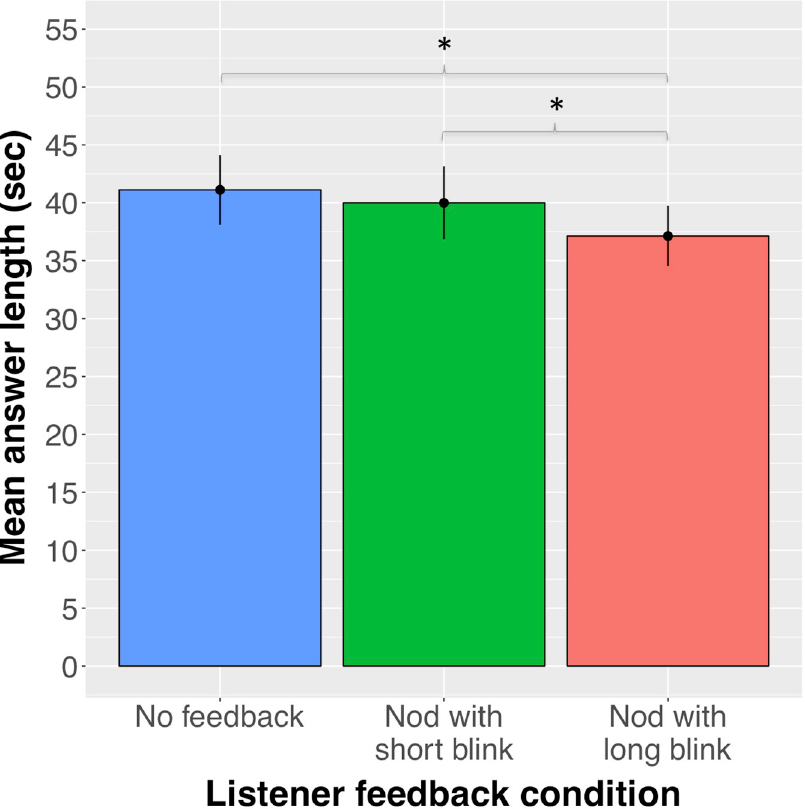
Fig 2. Mean answer length (sec) by listener feedback. Standard errors are represented in the figure by the error bars attached to each column.